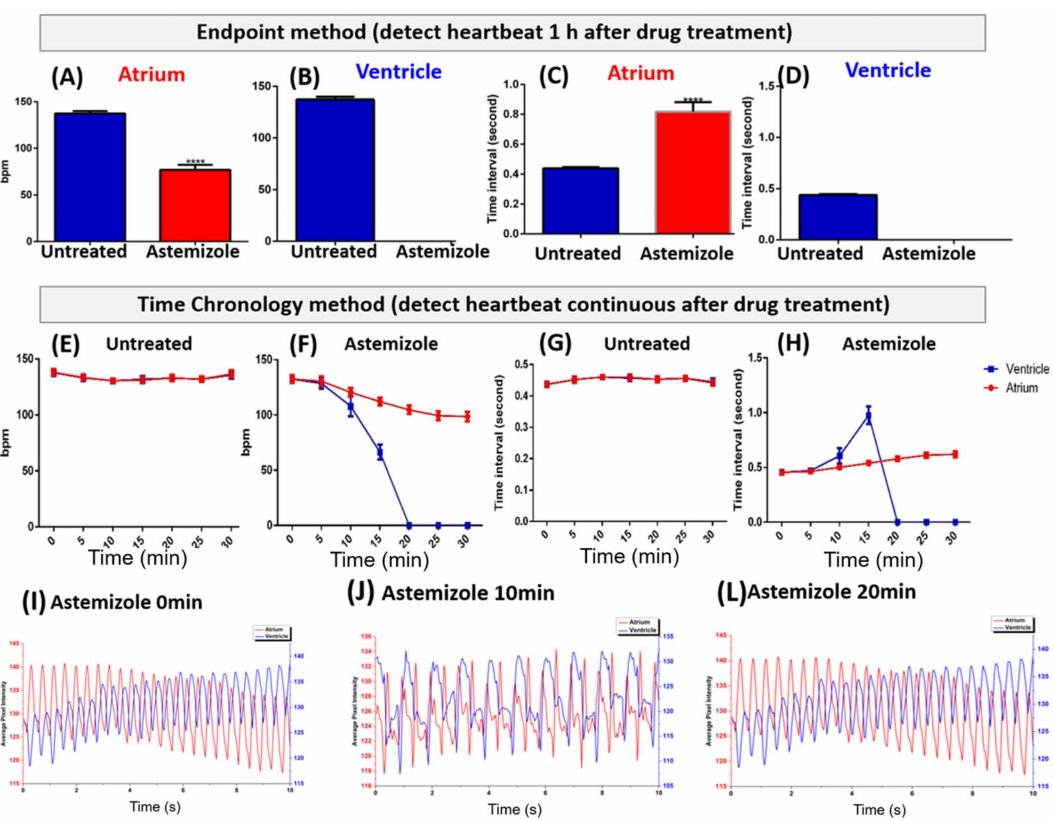
Figure 3. Endpoint and time chronological evaluation of astemizole on heartbeat in embryonic zebrafish 72 hpf. Atrium ( A , B ) and ventricle beat-per-minute (bpm) were compared between untreated control and 5 µ M astemizole-treated embryos after one hour of incubation. Atrium ( C ) and ventricle ( D ) beating time interval of untreated control and 5 µ M astemizole-treated embryos after one hour of incubation. Beat-per-minute ( E ) and time interval ( G ) in untreated control embryos in a chronological method. Beat-per-minute ( F ) and time interval ( H ) in 5 µ M astemizole-treated embyros in a chronological method; ( I – K ) is the dynamic pixel change patterns of the atrium and the ventricle after 0, 10 and 20 min astemizole treatment at 5 µ M concentration. The data are expressed as the means ± SEM and were analyzed by t -test (**** p < 0.0001, n =